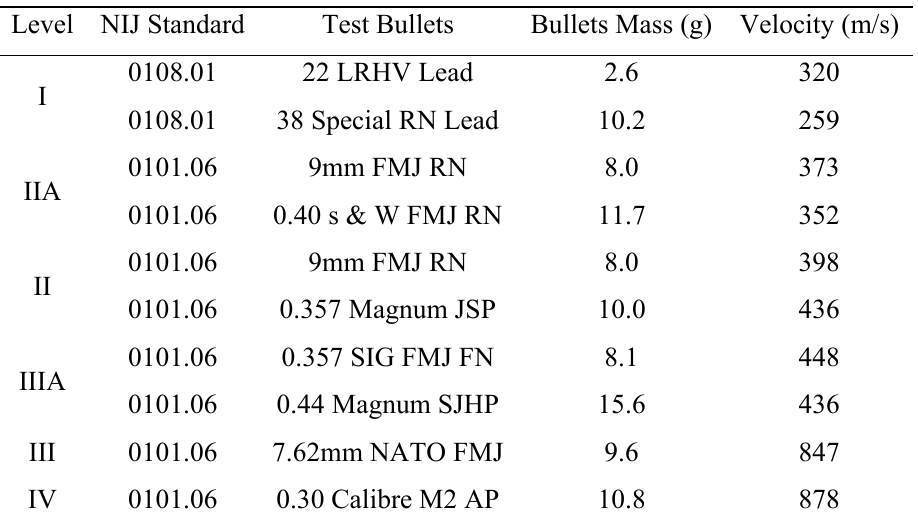
Table 1. NIJ Standard Ballistic Protection [1,13]